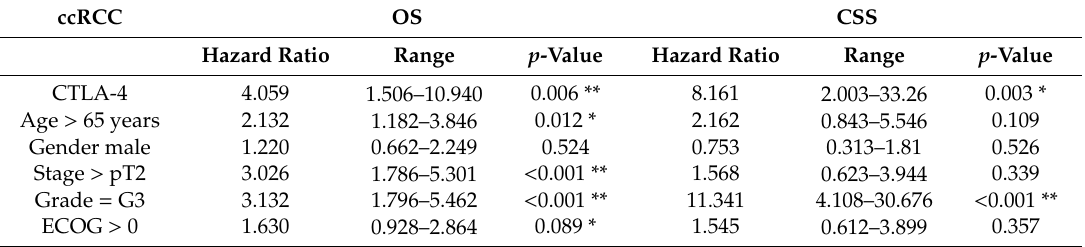
Table 7. Multivariate Cox regression analysis: Association of clinical parameters and CTLA-4 expression with OS or CSS in the ccRCC patients.